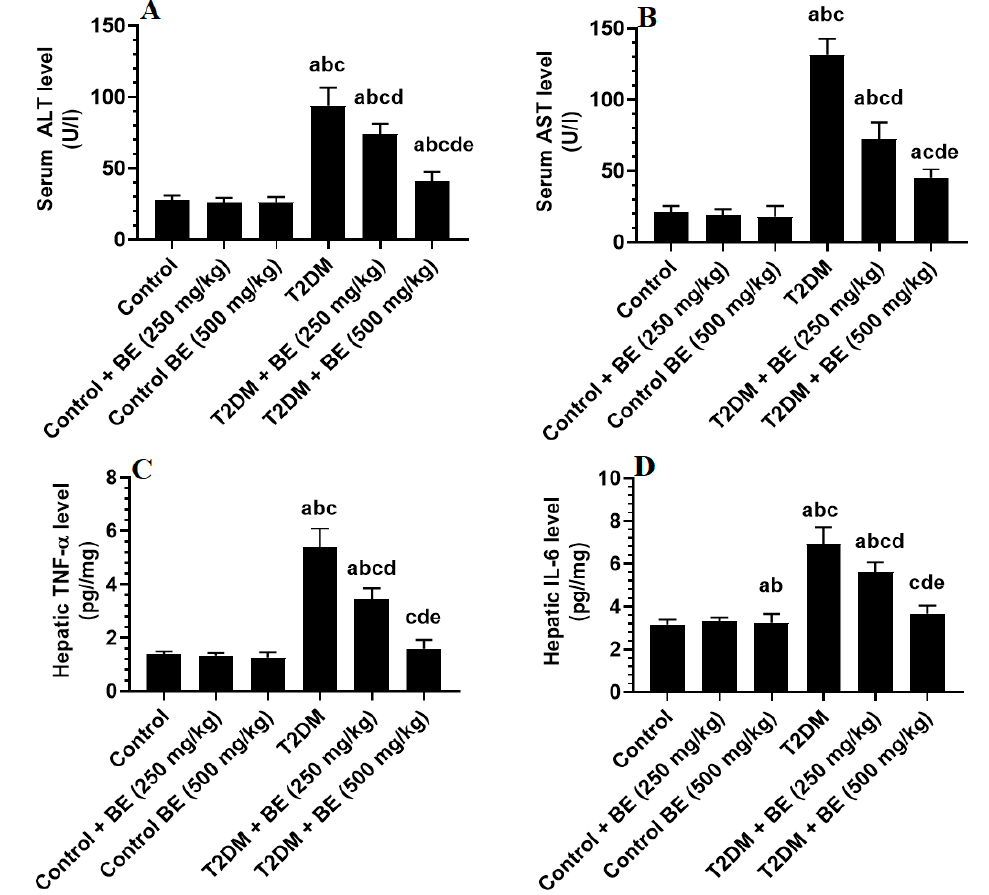
Figure 3. Serum levels of alanine aminotransferase (ALT) ( A ), aspartate aminotransferase (AST) ( B ), hepatic levels of tissue necrosis factor dismutase (TNF- α ) ( C ), and interleukin-6 (IL-6) ( D ) in all groups of rats. Data were analyzed by one-way ANOVA followed by Tukey’s test as post hoc and presented as mean ± SD of eight rats/group. a : vs. the control rats. b : vs. the control + beetroot extract (BE) (250 mg/kg)-treated rats. c : vs. the control + BE (500 mg/kg)-treated rats. d : vs. T2DM-treated rats. e : vs. T2DM + BE (250 mg/kg).